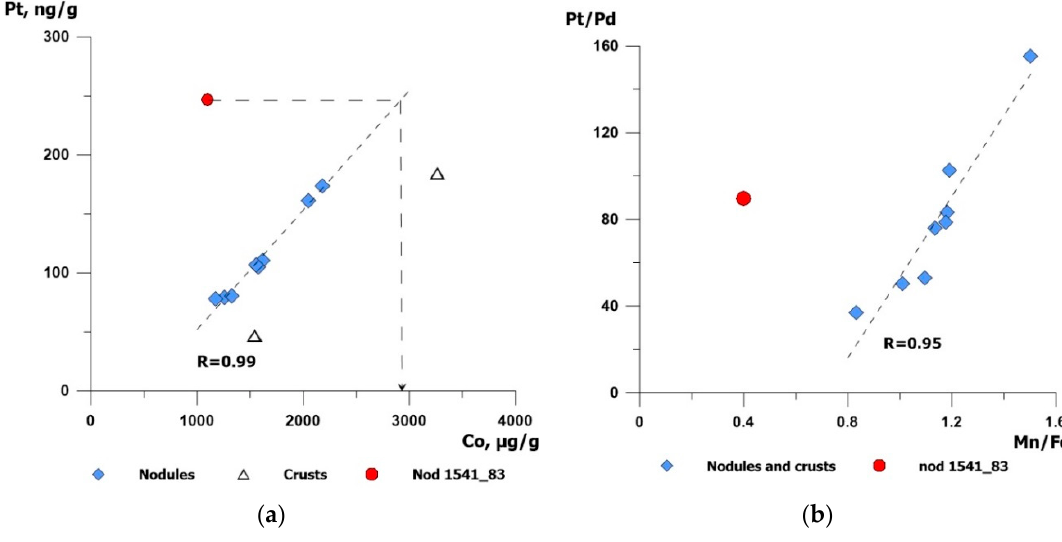
Figure 7. The relationship between Pt and Co ( a ) and Pt/Pd and Mn/Fe ( b ) in crusts and nodules from the Cape and Brazil Basins.